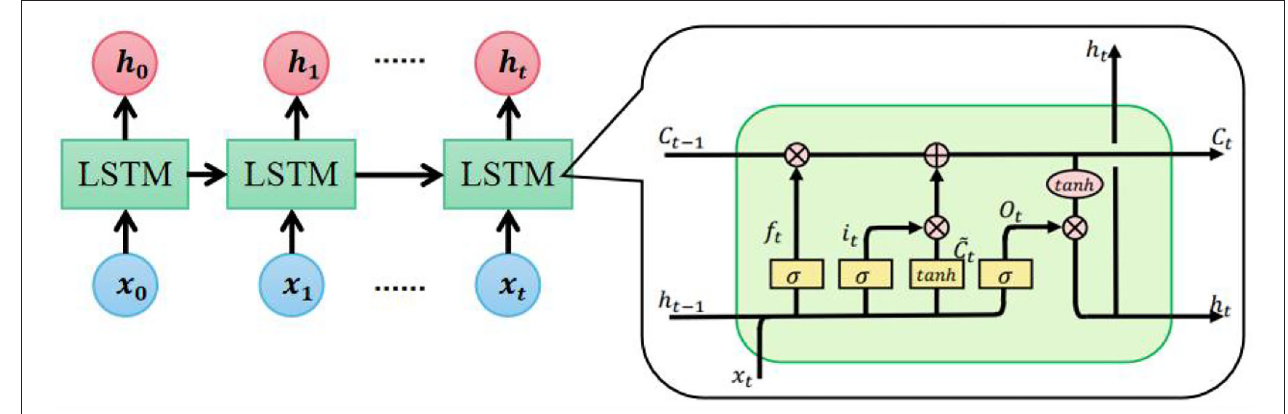
FIGURE 6 | Detailed structure of long short-term memory (LSTM) unit.